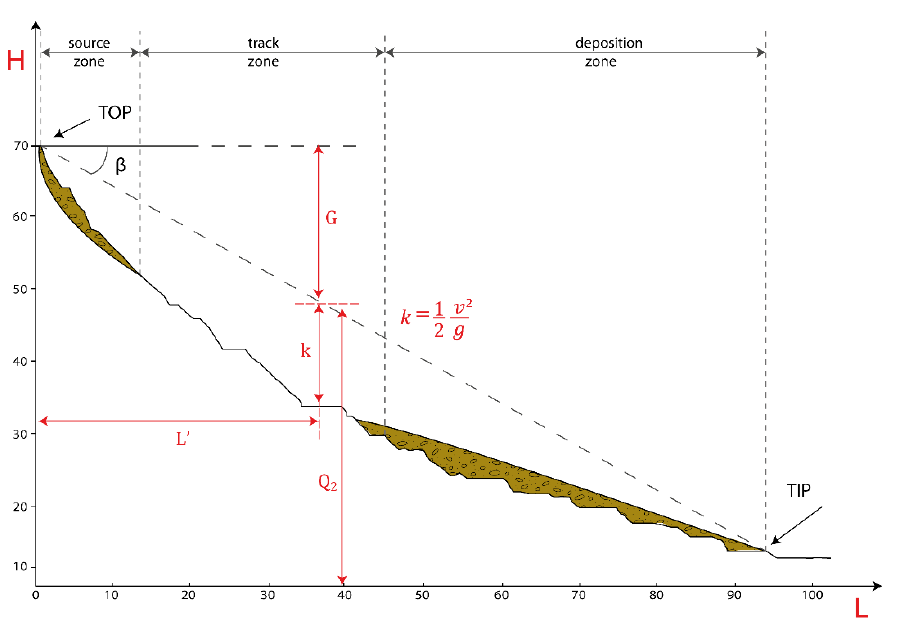
Figure 4. Graphical representation of a generic landslide based on the Heim Energy Line method; the parameters obtained with a specific Matlab routine are indicated.